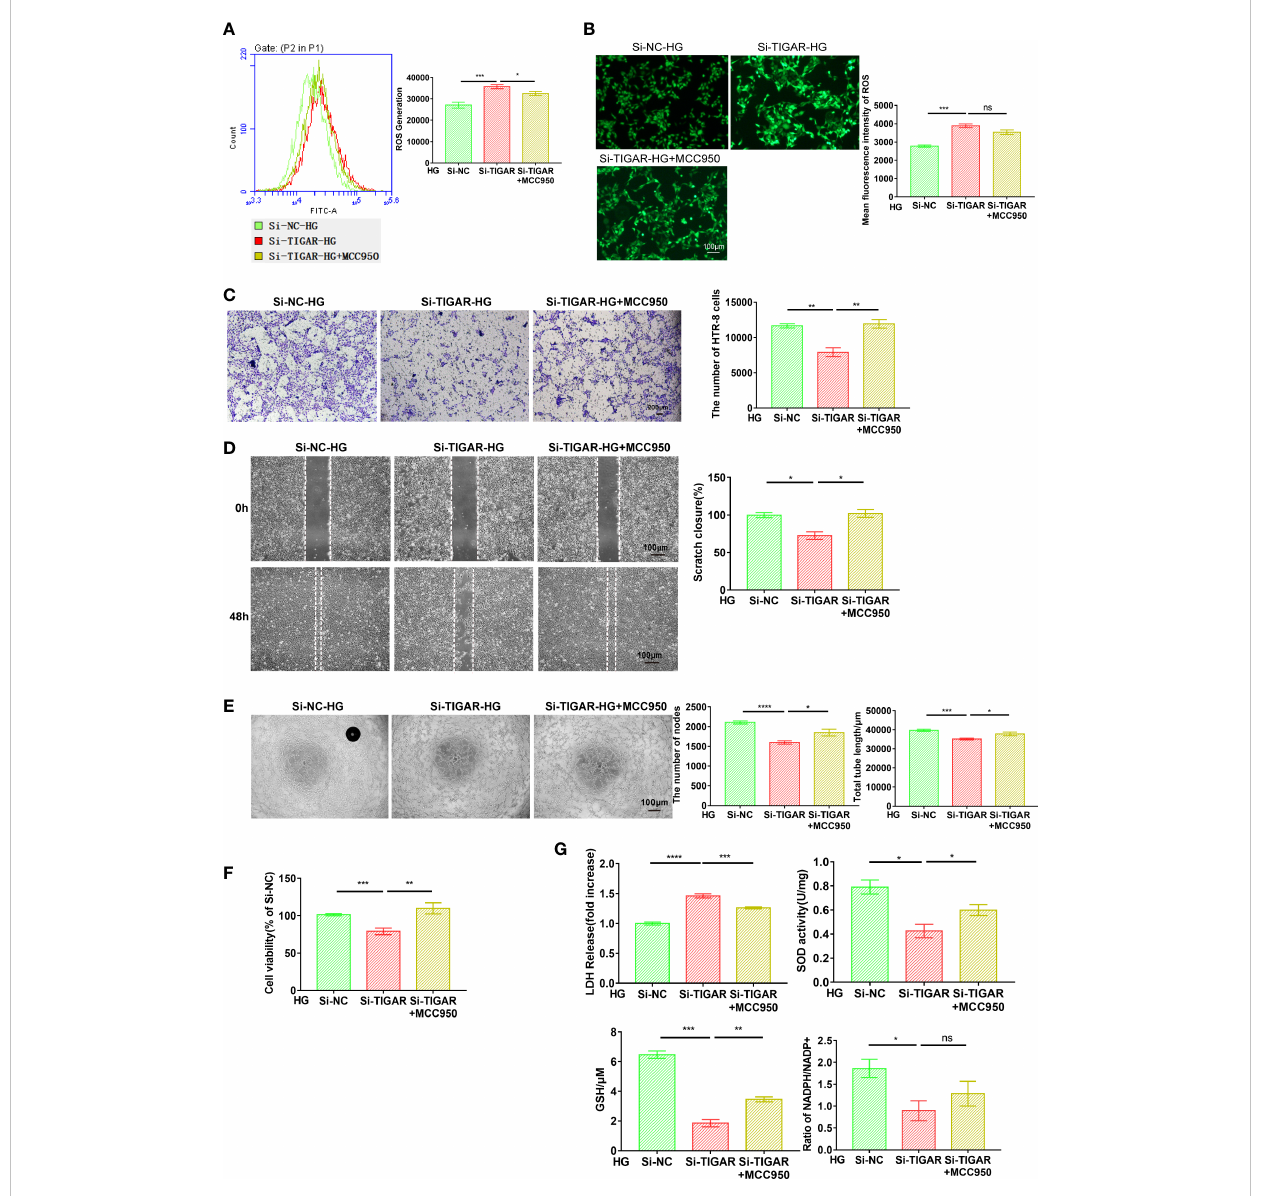
FIGURE 4 Loss of TIGAR mediated pyroptosis depends on the assembling of NLRP3 in fl ammasome. The detection of intracellular ROS in Si-TIGAR and Si-NC HTR-8 cells, which were pre-treated with MCC950 for 1 h then speci fi c medium were added, as measured by fl ow cytometry (A) and photograph (B) . The histogram shows the mean ROS production. Scale bar: 100 m m. The evaluation of cell function, as detected by cell invasion (C) (Scale bar: 200 m m), wound scratch assay (D) (Scale bar: 100 m m), and tube formation (E) (Scale bar: 100 m m). (F) CCK-8 assay showing the alteration of cell viability between groups (n=3) (G) LDH release, total SOD activity, GSH contents, ratio of NADPH/NADP + were measured after indicated treatment. Data of the triple experiments are presented as the means ± SEM. *p < 0.05, **p < 0.01, ***p < 0.001, ****p < 0.0001 versus the indicated group, ns, no signi fi